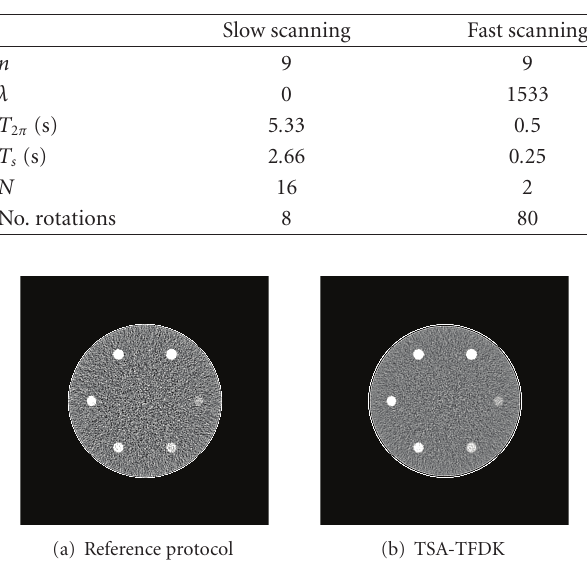
Figure 7: Comparison between reference protocol and low-noise reconstruction. (a) Frame of the sequence reconstructed with the reference protocol. (b) The same frame of the sequence recon- structed with fast scanning with TSA-TFDK. Window [30,70]